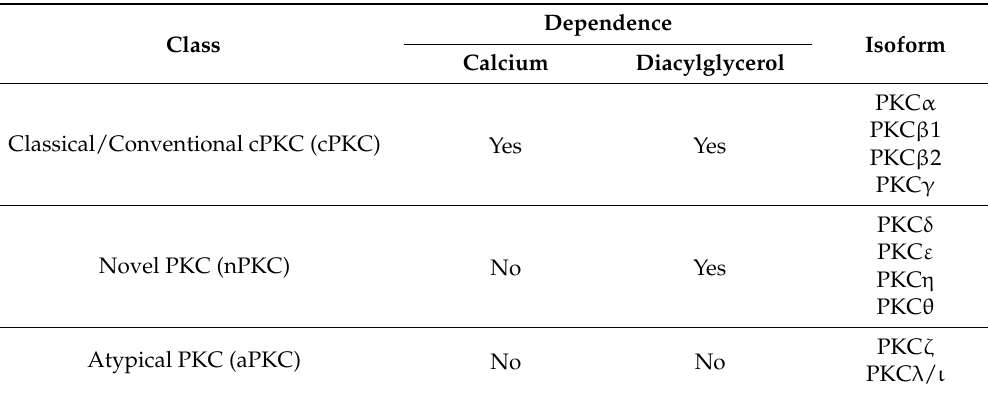
Table 2. Classification of protein kinase C (PKC) isoforms.